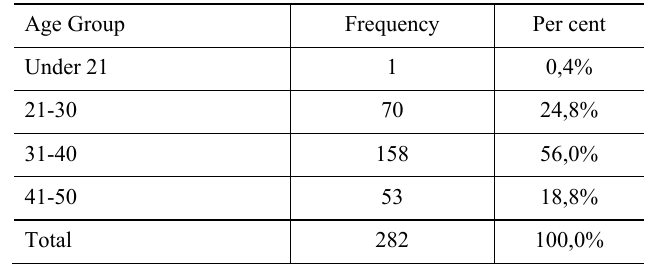
Table 1: Age of the respondents